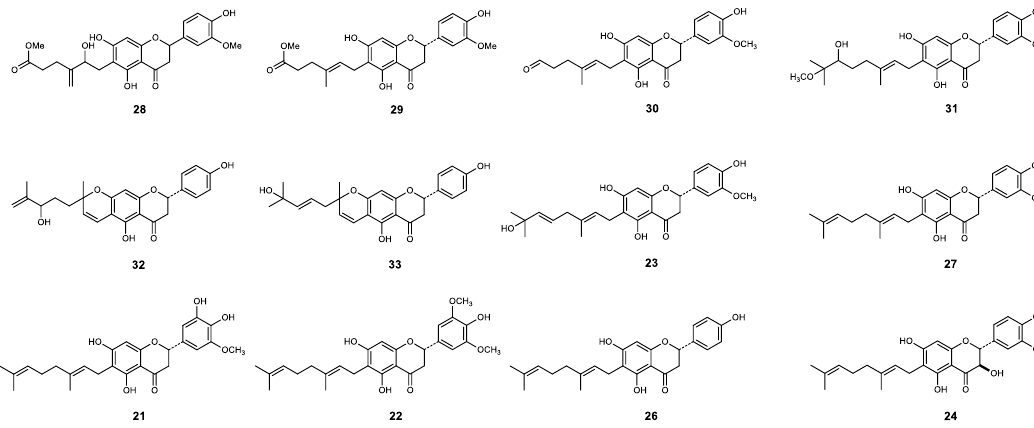
Figure 3. Chemical structures of compounds 21 to 24 , and 26 to 33 12 .